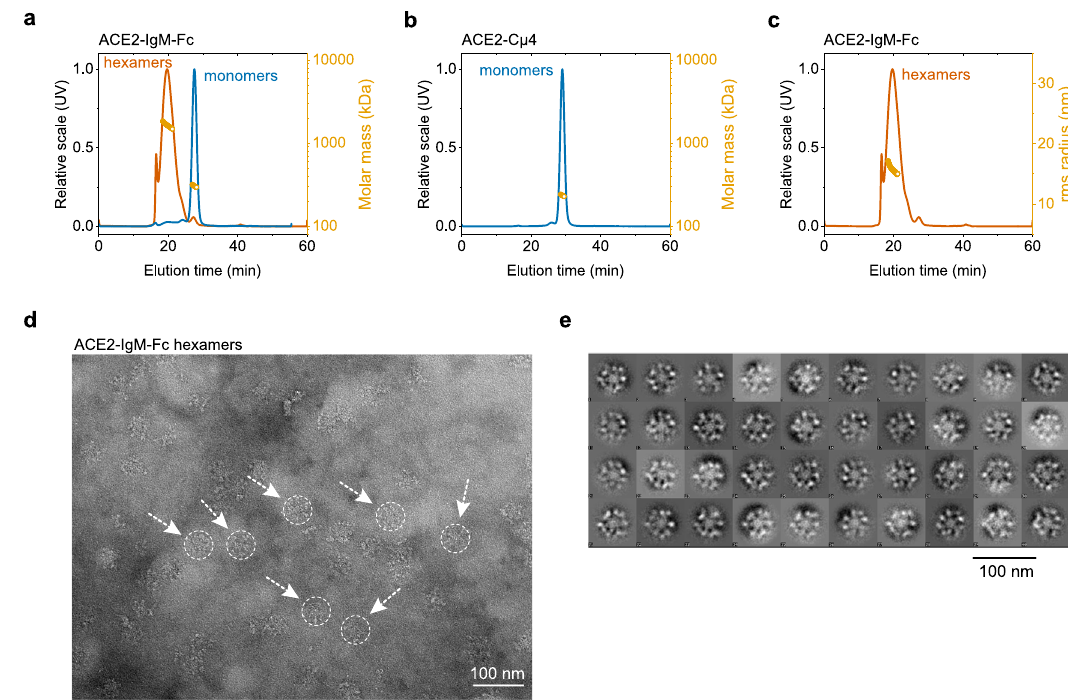
Fig. 2 Oligomeric state of ACE2-IgM fusions. a , b SEC-MALS chromatograms with calculated molecular masses. c SEC-MALS chromatogram with calculated rms radius. d Representative TEM image of ACE2-IgM-Fc hexamers. e Class averages of the ACE2-IgM-Fc hexamers observed in TEM.